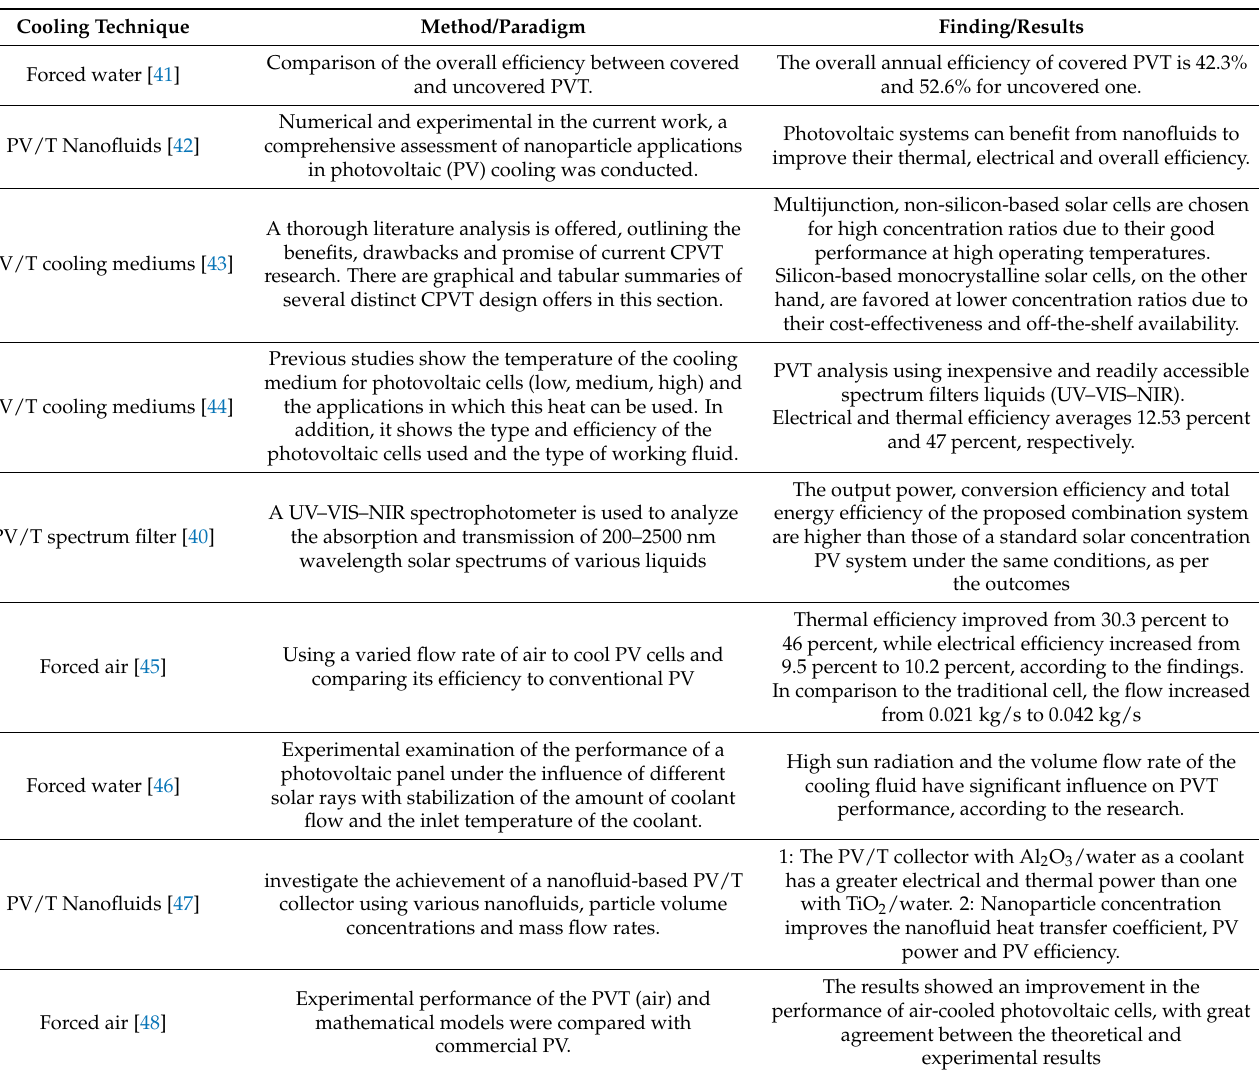
Table 2. Cooling technique